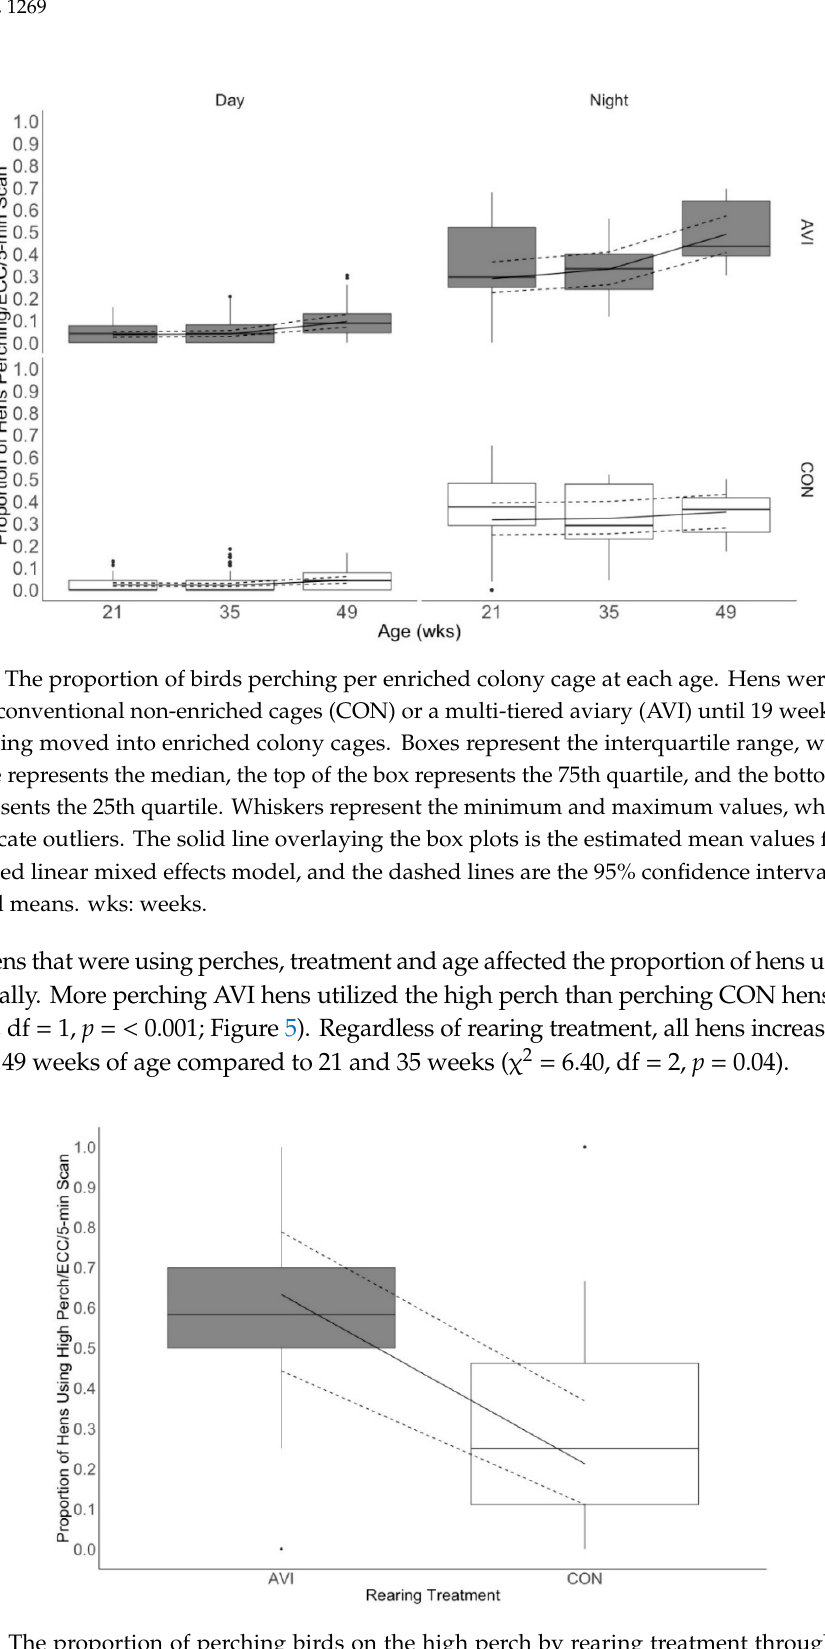
Figure 5. The proportion of perching birds on the high perch by rearing treatment throughout lay (21–49 weeks). Hens were reared in either conventional non-enriched cages (CON) or a multi-tiered aviary (AVI) until 19 weeks of age before being moved into enriched colony cages. Boxes represent the interquartile range, where the black line represents the median, the top of the box represents the 75th quartile, and the bottom of the box represents the 25th quartile. Whiskers represent the minimum